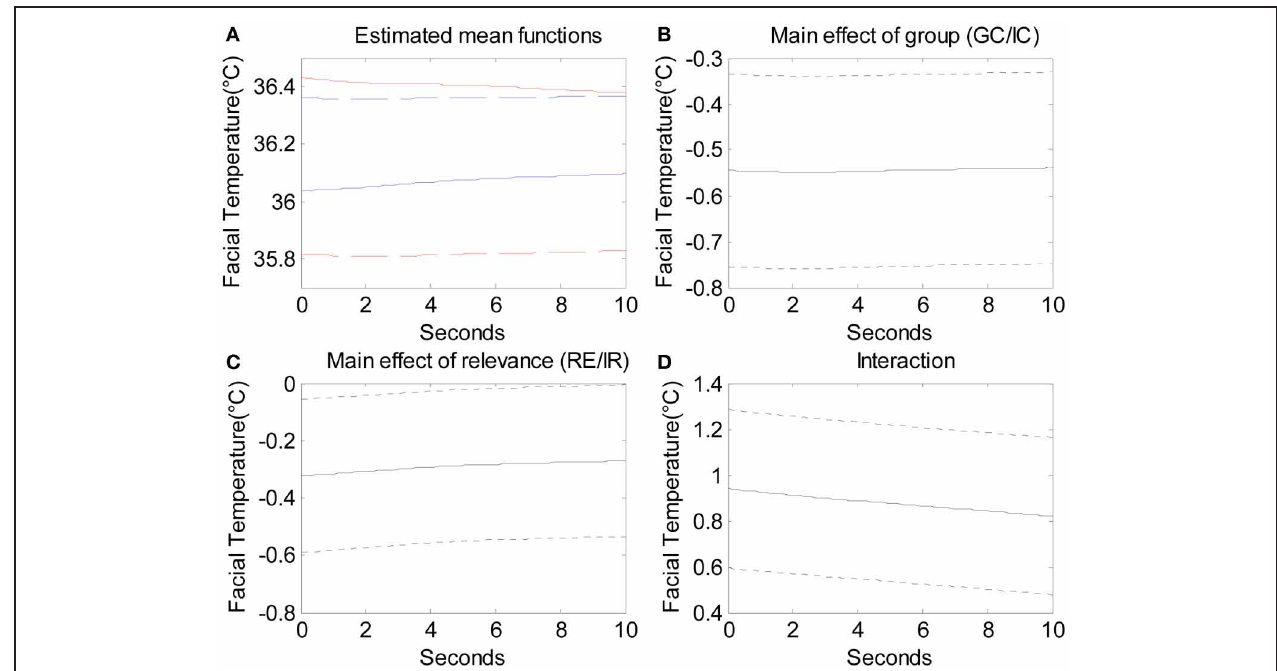
FIGURE 7 | (A) The estimated mean functions of the four conditions. From the top, solid red line indicates the mean function of GC-RE, blue dashed line IC-IR, blue solid line IC-RE, and red dashed line GC-IR. (B) The main effect of condition (GC/IC; solid line) with 95% pointwise confidence